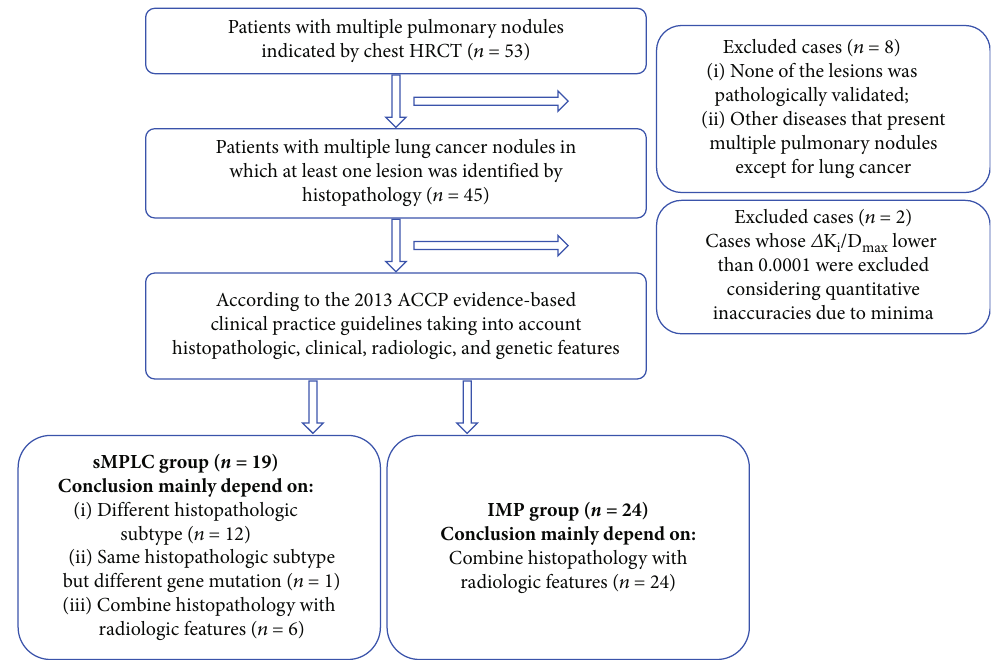
Figure 1: Diagram of case inclusion and